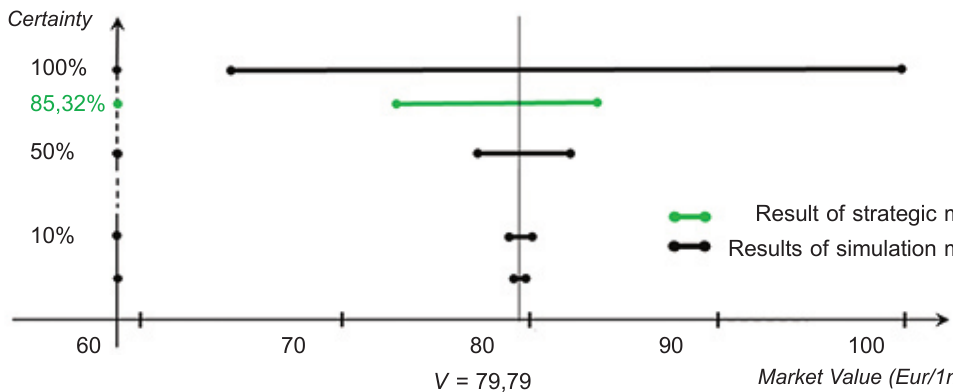
Figure 6. comparison of the results obtained in effect of the applied simulation